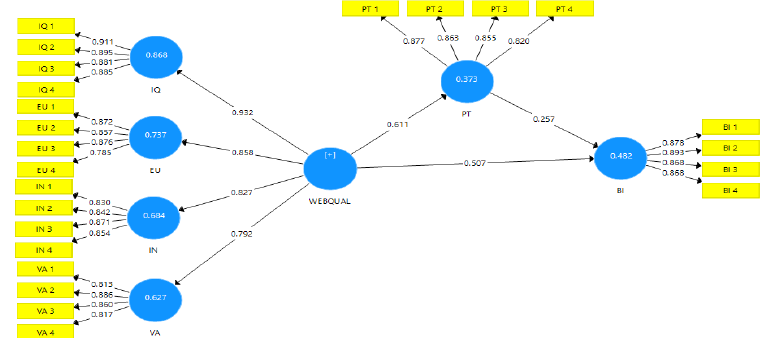
Fig. 2. The model of